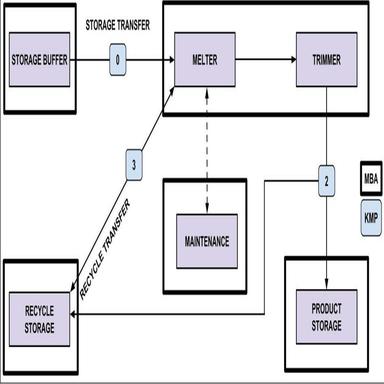
Equipment Design. Only one MBA is installed around both the melter and the trimmer. KMP1 previously installed between the melter and the trimmer is removed, and other conditions follow the same as ones that are for the baseline design.